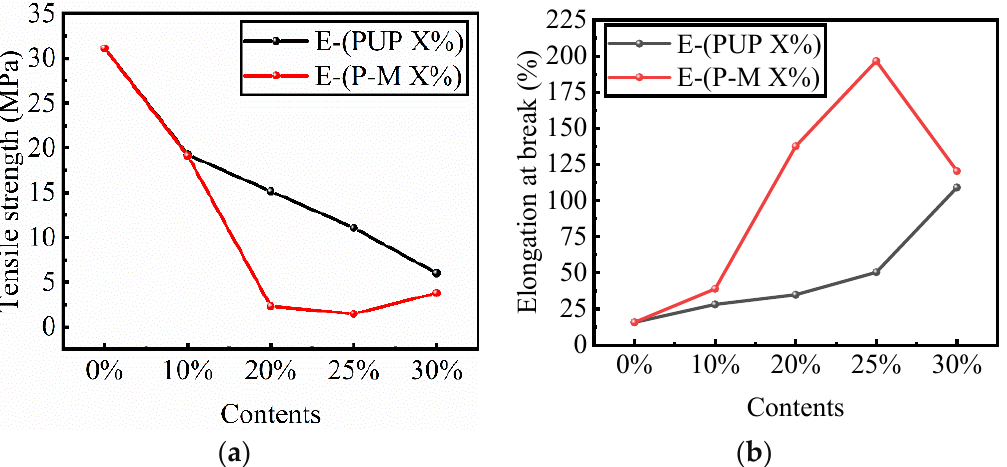
Figure 4. Tensile strength and elongation at break of the modified EP. ( a ) Tensile strength, ( b ) elongation at break.